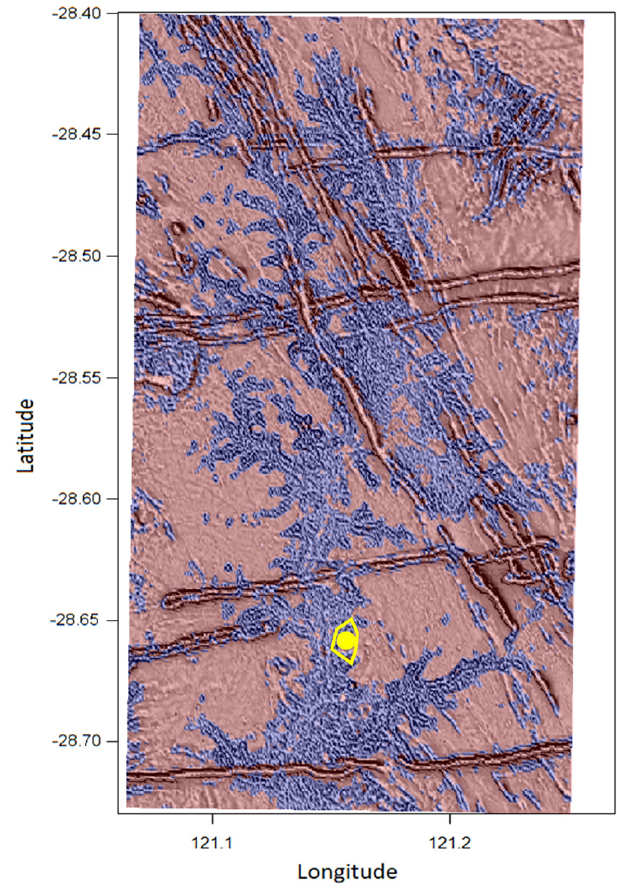
Figure 5. The predicted results of the SRF classifier were draped over the high-resolution aeromagnetic data. The blue colour represents areas predicted as the positive class— mapping the extent of the magnetic gravels—and the red colour represents the areas predicted as the negative class, devoid of these gravels. The majority of the dendritic and noisy patterns related to the inset-valley ferricretes units are accurately predicted. Table 3 shows the confusion matrix for the SRF classifier on the basis of the validation dataset from the Tarmoola area. The overall accuracy of the SRF model in this area was 91.9%.